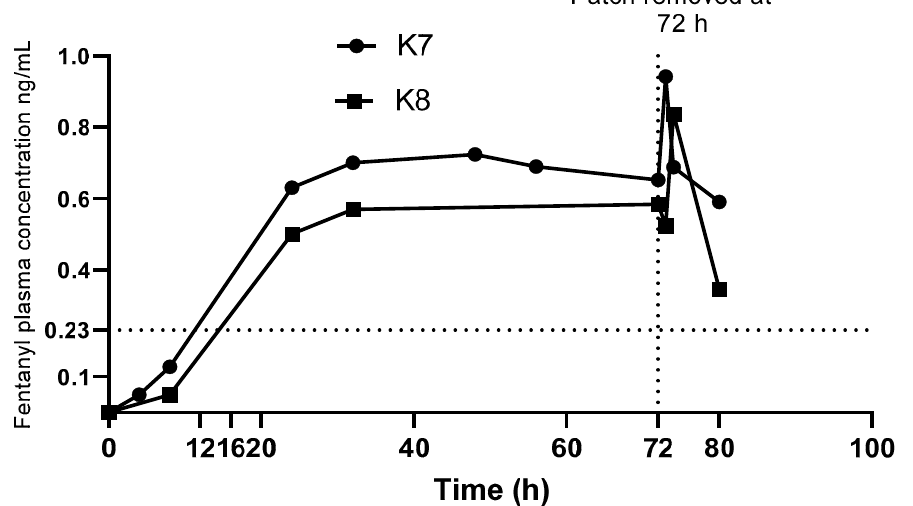
Figure 3. Fentanyl c oncentration vs time after transdermal fentanyl patch (TFP), (with a delivery rate of 25 μ g/h), application and removal for both koalas. Dotted lines at 0.23 ng/mL denote suggested minimal analgesic range in human patient controlled analgesia models (see Discussion).